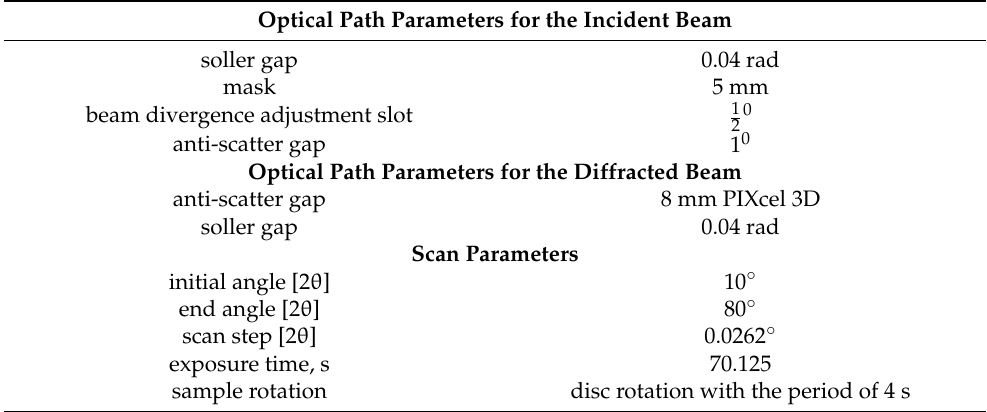
Table 4. Optical settings and scan parameters of the powder diffractometer (Empyrean,